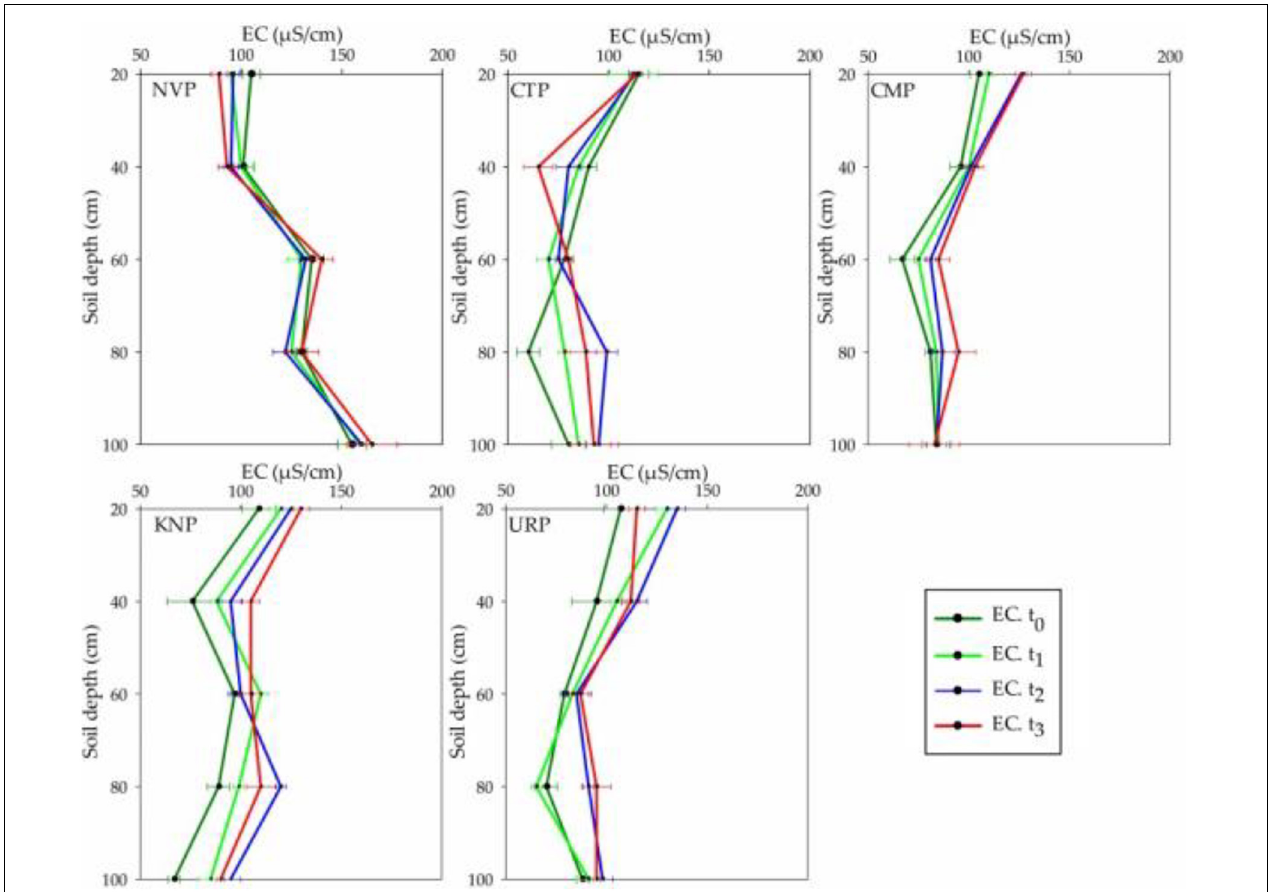
FIGURE 3 | Soil electrical conductivity (EC) mean values with standard error bar in soil profile (0–100 cm) at t 0 , t 1 , t 2 , and t 3 for the treatments during the Chinese cabbage production in Shunyi District,